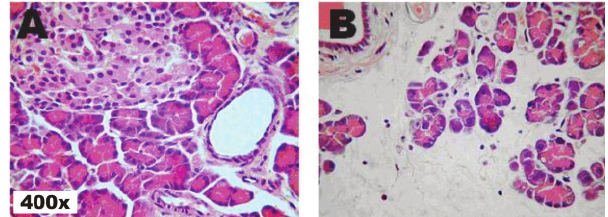
Figure 2. Micrography of pancreas histology of: Group I (A; minimal edema) and Group II (B; pronounced edema) rats. The pancreas segments were stained with a hematoxilin-eosin